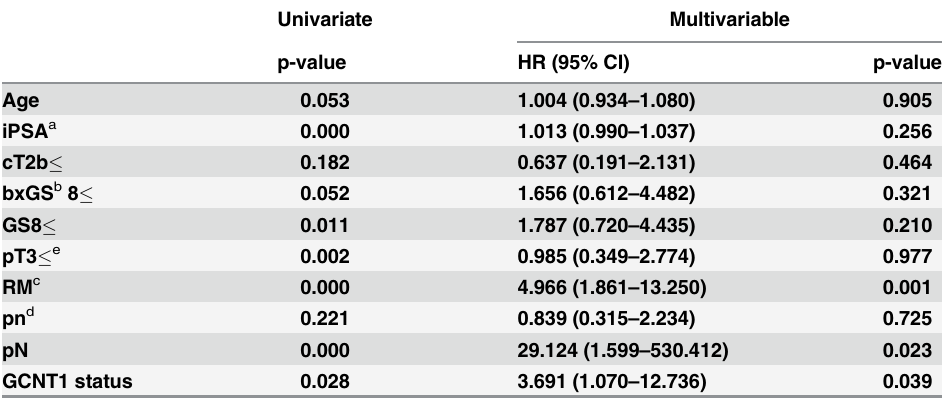
Table 1. Univariate and multivariable analyses of risk factors for prostate-specific antigen recurrence. Univariate